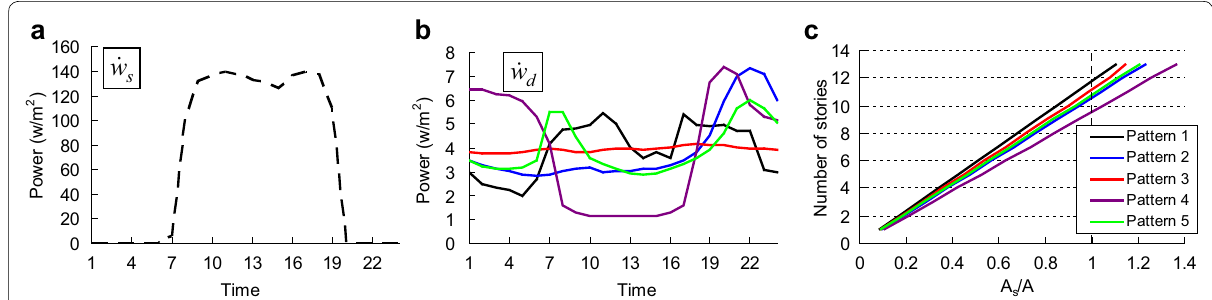
Fig. 3 Electric power cycle for 24 h period: a supply from solar panel; b demand from consumption; c normalized required area of the solar panel vs. number of